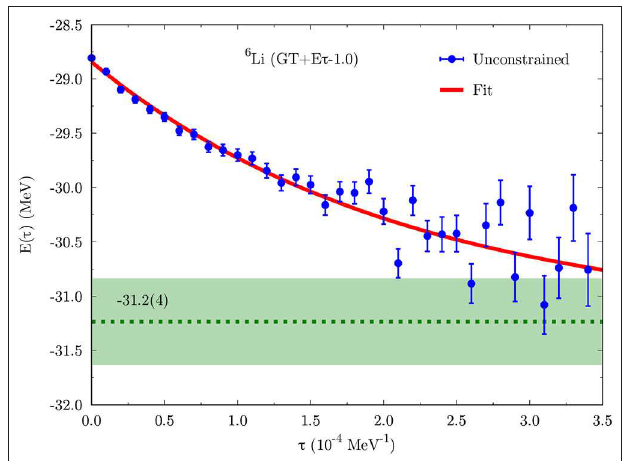
FIGURE 1 | Unconstrained evolution in 6 Li for the GT+E τ -1.0 local chiral Hamiltonian. Blue dots with error bars bands are AFDMC energies. The red curve is a single-exponential function fit to the AFDMC results. The green band represents the final energy result including the uncertainty coming from the fitting